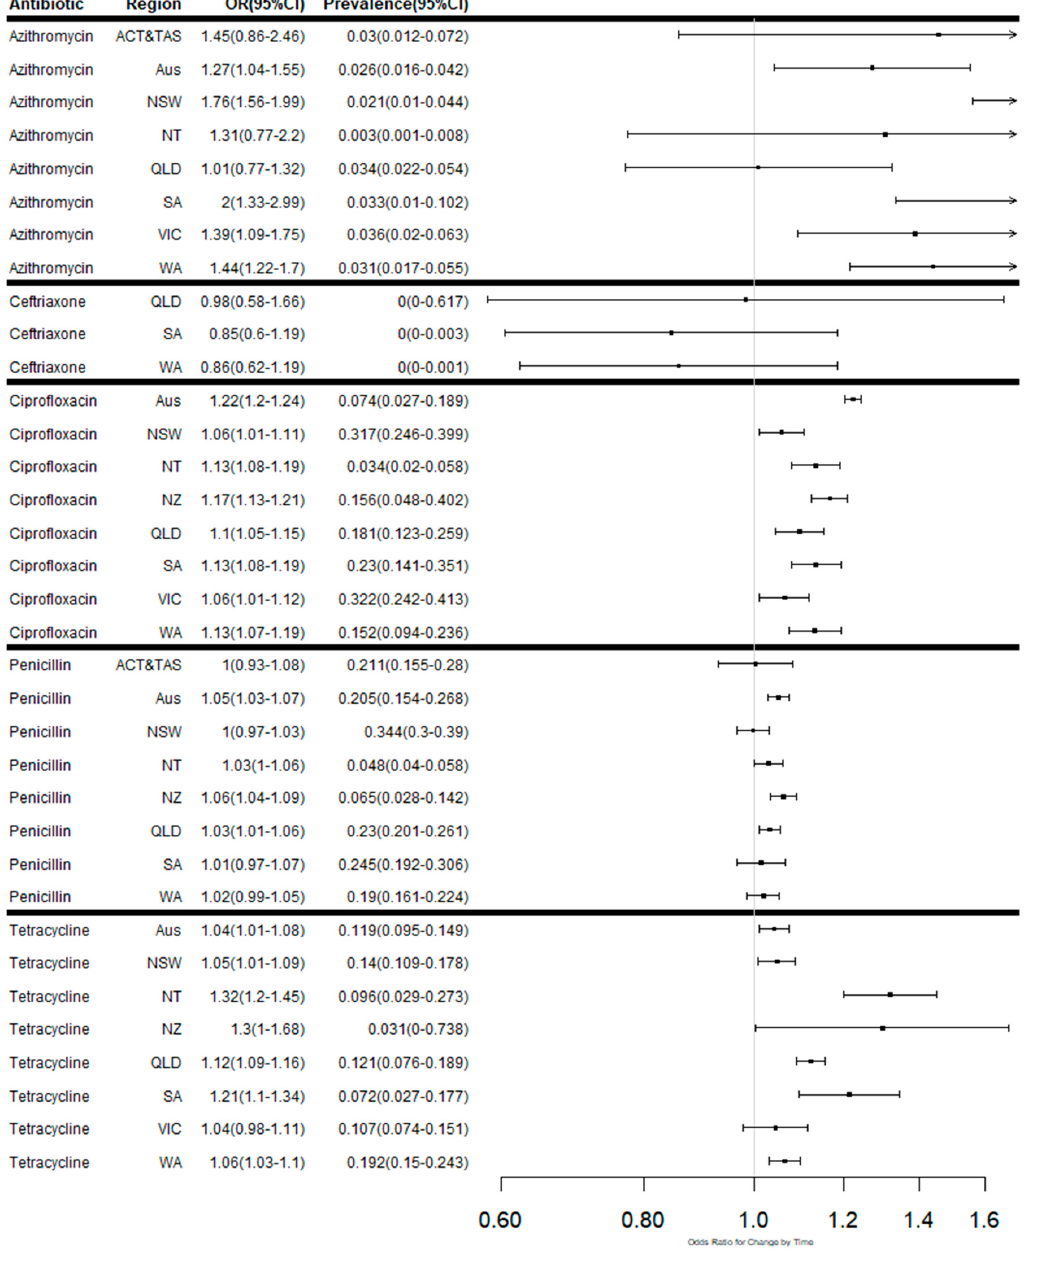
Figure 4. Meta-regression plots showing the odds ratios for changes in proportion and weighted average proportions of isolates resistant to each antibiotic over time in Australia, Australian states and territories and New Zealand.